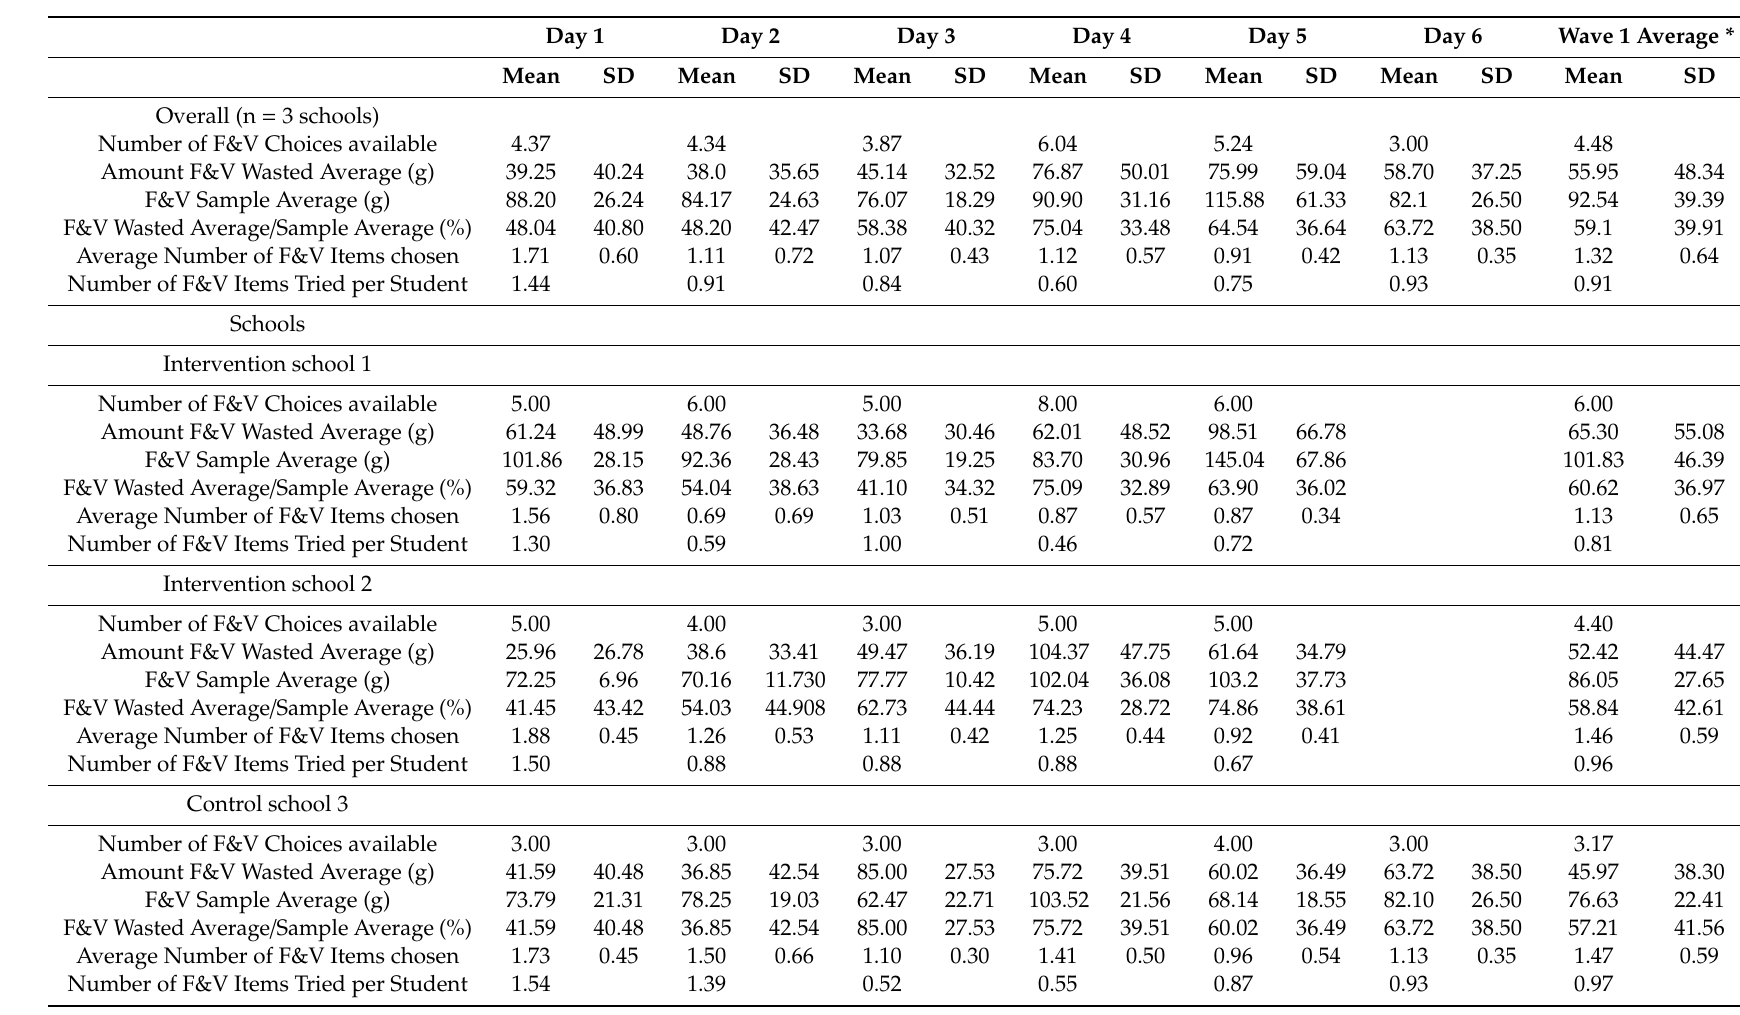
Table 3. Food Waste Descriptives stratified by school and school district at baseline,